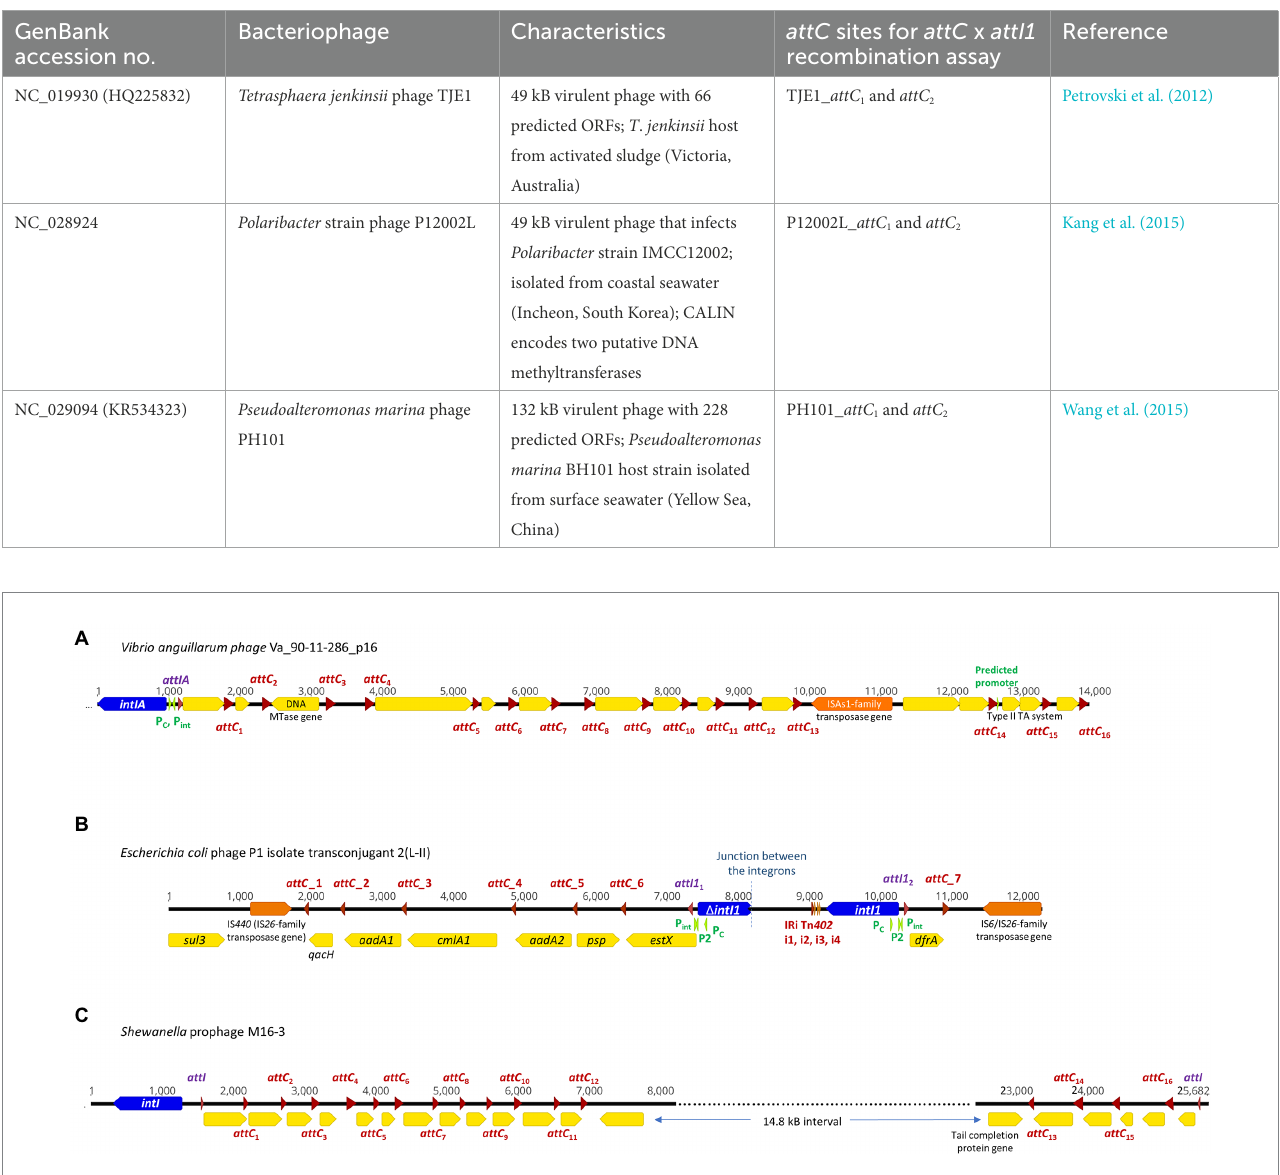
FIGURE 1 Complete integrons and integron-integrase that does not carry gene cassettes (In0 element) were predicted in four temperate phage genomes. The integron-integrase genes are in blue, the attC sites are represented by red arrows, and attI1 sites by purple arrows. The open reading frames (ORFs) are shown in yellow, and the promoters in green. ORFs encoding predicted DNA methyltransferases (MTase) and toxin-antitoxin modules are specified. Nucleotide numbers are shown above each schematic diagram. (A) The functional V . anguillarum phage Va_90–11–286_p16 carries a complete Vibrio - type integron; its gene cassette array is a subset of the chromosomal integron in the host genome. The double-ORF encoding a type II toxin-antitoxin system has its own predicted promoter within that gene cassette. (B) E . coli phage P1 isolate transconjugant 2 (L-II) contains fragments of two class 1 integrons, with their boundary represented by the dotted line. attC _1, 2, 4 and 5 can be classified as the Xanthomonadales type (Ghaly et al., 2021b). (C) Shewanella sp. prophage M16-3 contains a complete integron and a CALIN, each with its own attI site and integron gene cassette